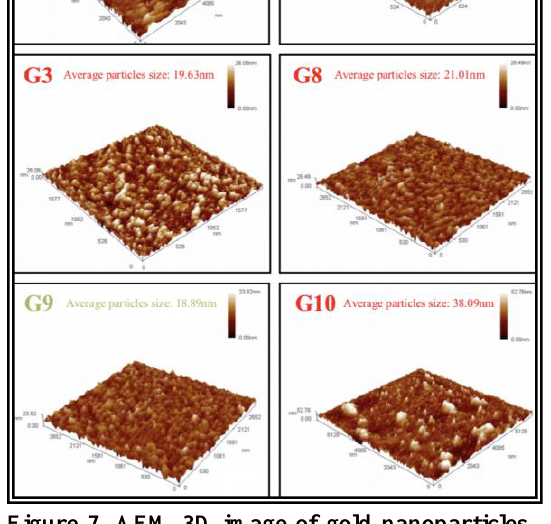
Figure 7. AFM 3D image of gold nanoparticles G3, G6-10